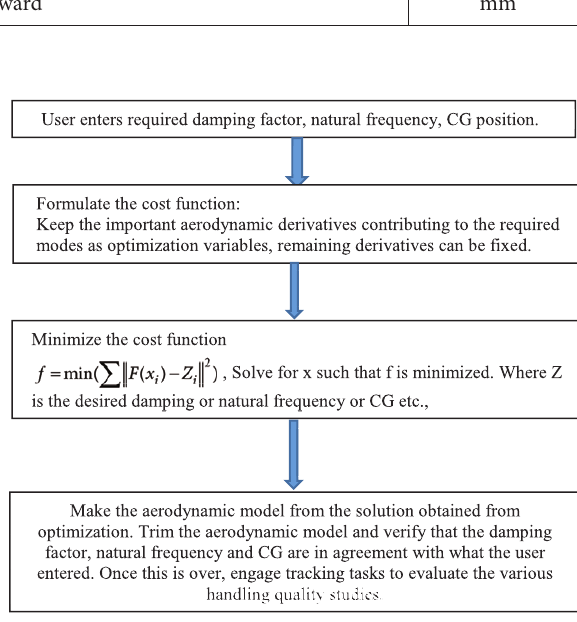
Figure 3. Work flow diagram for creating a variable stability aircraft